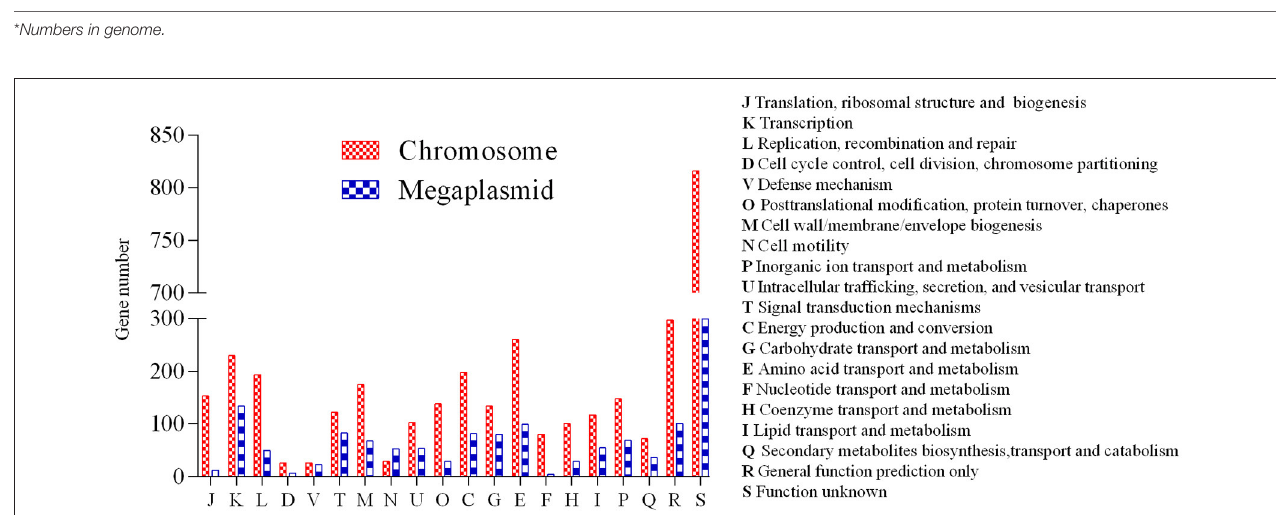
FIGURE 2 | Distribution of genes in different COG functional categories between the chromosome and the mega-plasmid in strain EP1 .